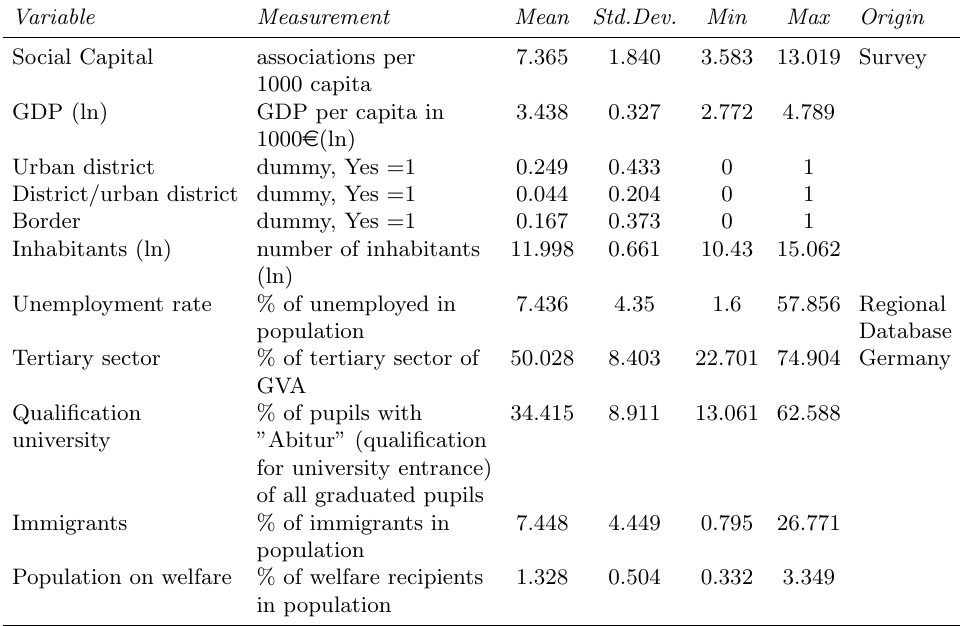
Table A.1: Descriptive statistics of